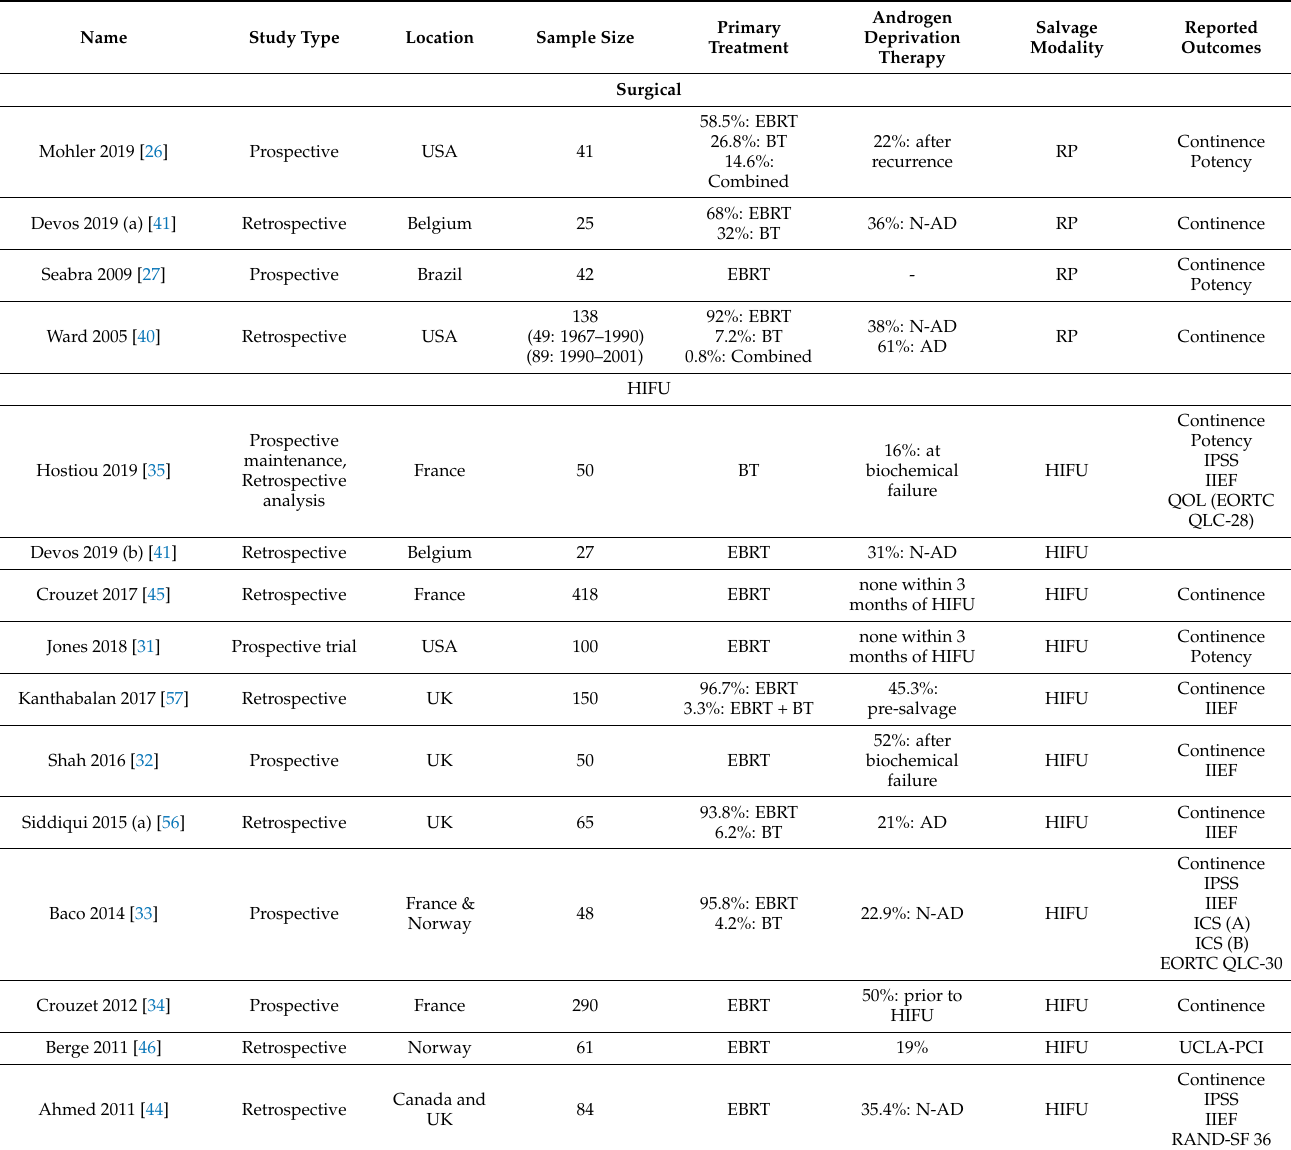
Table 1. Characteristics of studies assessing the functional outcomes in patients who underwent salvage intervention after radiation recurrent prostate